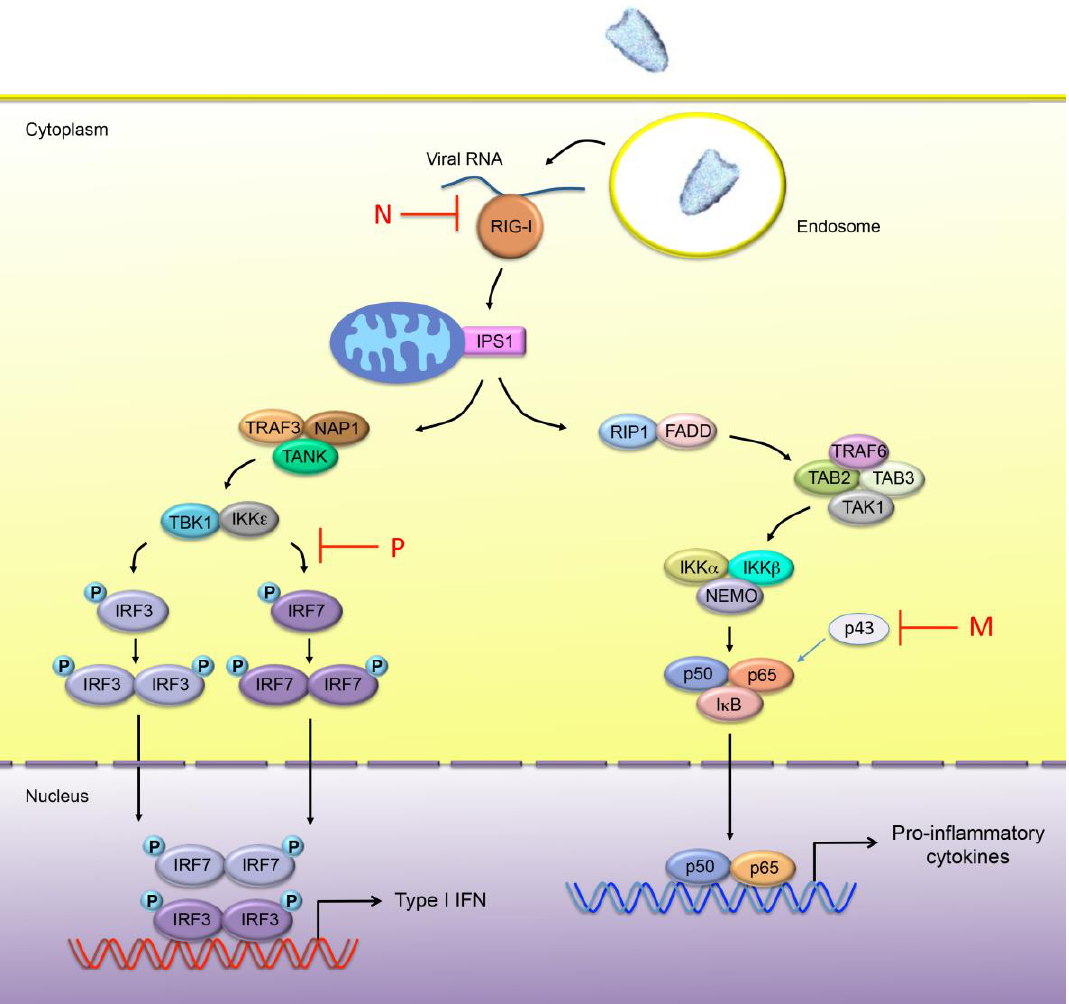
Figure 2. Innate immune sensing of rhabdovirus infection. In rhabdovirus-infected cells, the viral RNA is mainly detected by RIG-I. Once activated, RIG-I binds to the CARD containing adaptor protein IPS-1 (also known as MAVS, CARDIF or VISA), which phosphorylates IRF3 and/or IRF7 through TRAF3, NAP1 and TBK1/IKKε. Phosphorylated IRF3 and IRF7 homodimerize and translocate into the nucleus where they induce the expression of Type I IFN genes. IPS-1 also interacts with FADD, a death domain-containing adapter involved in death receptor signaling, and RIP1, which induces the activation of the NF-κB pathway. NF-κB is composed of homo- and heterodimeric complexes of members of the Rel family. The most common and best-characterized form of NF-κB is the p65/p50 heterodimer. A new member RelAp43 (p43) of the NF-κB family has been recently identified. Activation of the IκB kinase (IKK) complex, consisting of catalytic kinase subunits (IKKα and/or IKKβ) and the regulatory non-enzymatic scaffold protein NEMO, results in the phosphorylation and subsequence degradation of IκB. This enables free NF-κB to translocate to the nucleus, where it induces target gene expression, including pro-inflammatory cytokine encoding genes. The steps inhibited by the RABV-N and -P proteins, as well as VSV M protein are indicated in the diagram above.